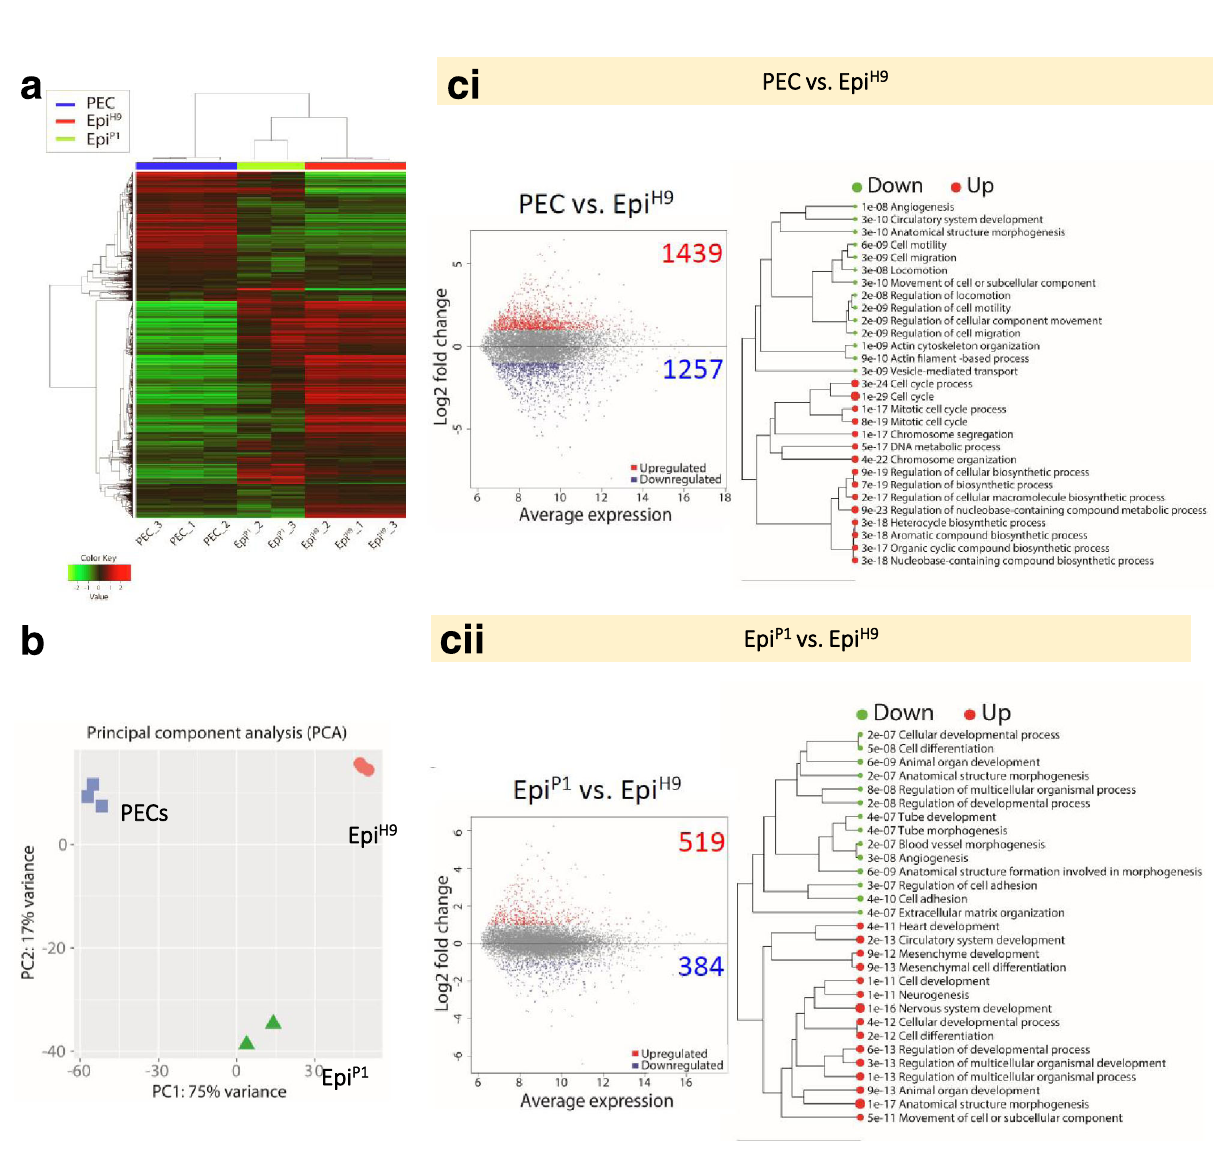
Fig. 2 RNA Sequencing analysis and functional interpretation. a Unsupervised hierarchical clustering of 2,000 most variable genes based on correlation distance (average linkage) method. Replicates for each group were from independent differentiation batches. b Principal component analysis (PCA) cluster PECs closer to Epi P1 as compared to Epi H9 . c MA plots of differential expression analysis for PEC vs Epi H9 (i) and Epi P1 vs Epi H9 (ii) comparisons. Differentially expressed genes (DEGs) are highlighted as red dots for upregulation and blue dots for downregulation (adjusted p value < 0.05 and absolute fold change ≥ 2). Functional clustering of gene ontology terms for biological processes for both up and downregulated DEGs for PEC vs Epi H9 and Epi P1 vs Epi H9 comparisons. DEGs were determined using DeSeq2 and analyzed using the Wald test with Benjamini-Hochberg multiple comparison corrections. FDR value = 0.05 was used as to determine the statistical signi fi change of DEGs obtained from PECs vs. Epi H9 , Epi P1 vs. Epi H9 , 9-97 lines), hESC-derived (Epi SC from H9 and ES03 lines), and donor-derived (Epi DONOR from Donor9635, Donor9634, and Epi DONOR vs. Epi SC were employed for comparisons to avoid Donor9633, and Donor9605) published by the Palecek group batch effect between the two independent studies. K-means (GSE84085) were included in our analyses 32 . The log 2 fold- clustering was performed on all the DEGs and functionally group